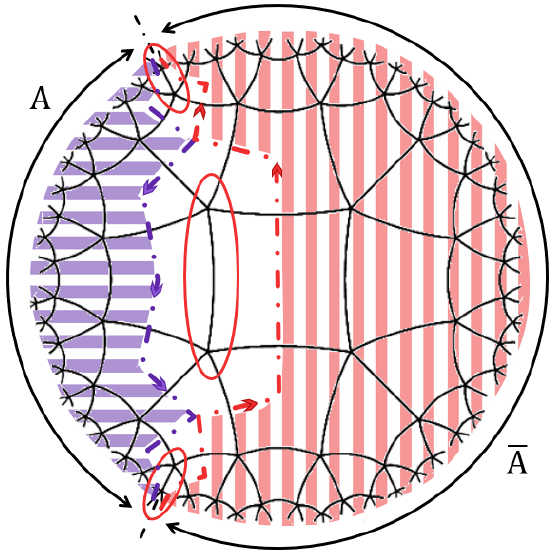
Figure 28 . In the tensor network with f 4 ; 5 g tiling and (cid:20) c < 5 = 2, several protected tensor chains h 2 2 i M p = are marked by the red loops. For the choice of interval A , the cut C A marked by purple 2 2 dashed lines and the cut C (cid:22) marked by red dashed lines are A